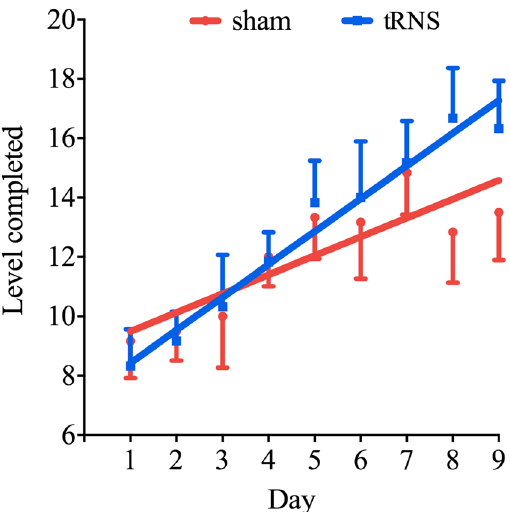
Figure 3. Steeper learning with tRNS. Children in the real tRNS group showed a steeper learning slope compared to those in the sham group. Data points indicate the averaged group level at the end of each training day. Error bars indicate one standard error of the mean